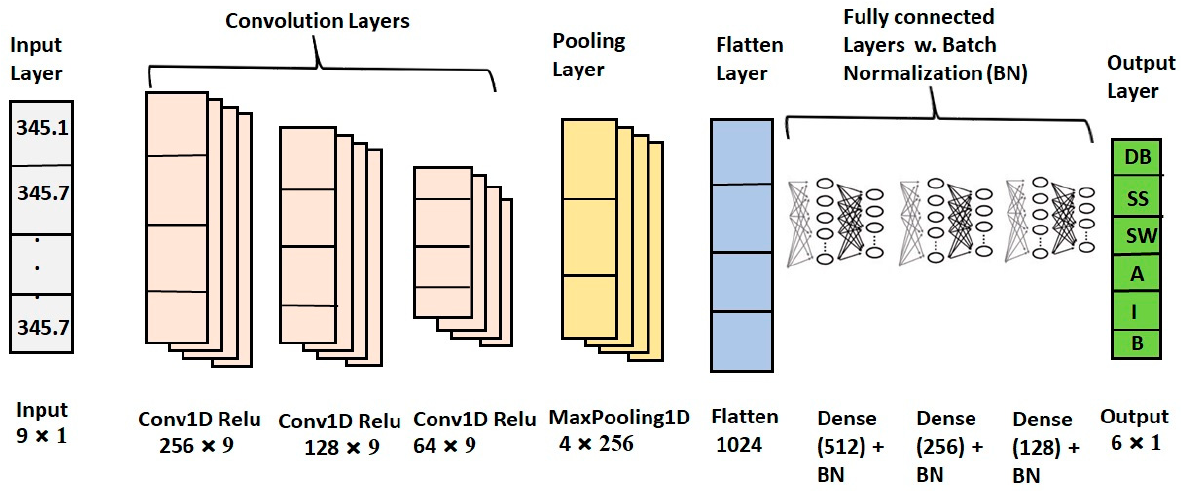
Figure 6. CNN model architecture for six-class